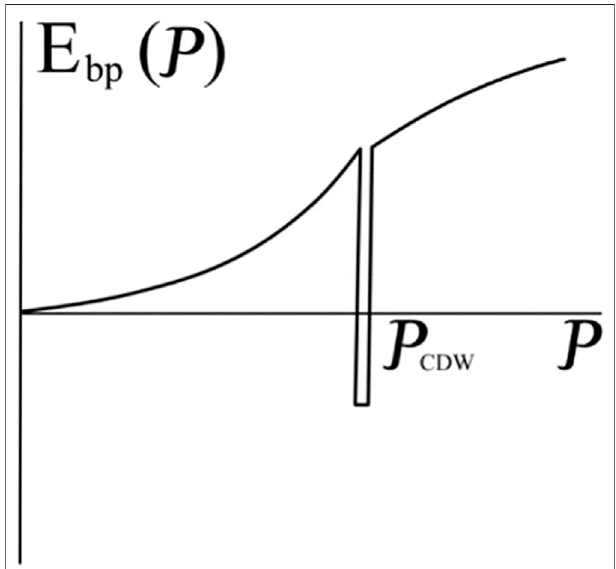
FIGURE 1 | The suggested TI-bipolaron spectrum for a charge density wave. It looks as the roton spectrum, but is sharper at (cid:2) P (cid:1) (cid:2) P CDW due to the Kohn